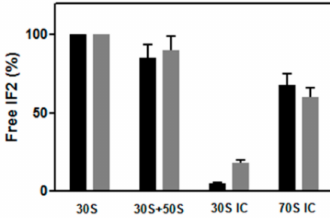
Figure 6. Dissociation of wtIF2 from the ribosomes. The histogram bars represent the amount of free (i.e., not ribosome-bound) wtIF2 present in the post-ribosomal supernatant after ultracentrifugation of samples containing 1 mM GTP (black bars) or 1 mM GDP (gray bars) and as indicated: wtIF2 and 30S ribosomal subunits; wtIF2, 30S and 50S ribosomal subunits; wtIF2 and all the components necessary for the formation of a 30S IC; wtIF2, 30S IC and 50S subunit forming a 70S IC. The amounts of free IF2 detected in the samples containing only 30S subunits are taken as equal to 100% and the amounts of free IF2 detected in the other samples are expressed as % of this amount. More experimental details are given in Materials and Methods.